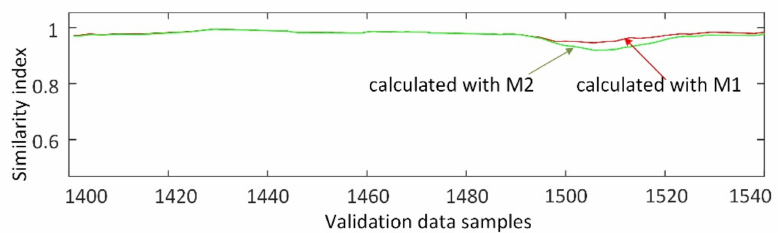
Figure 9. Similarity index values of the validation dataset.